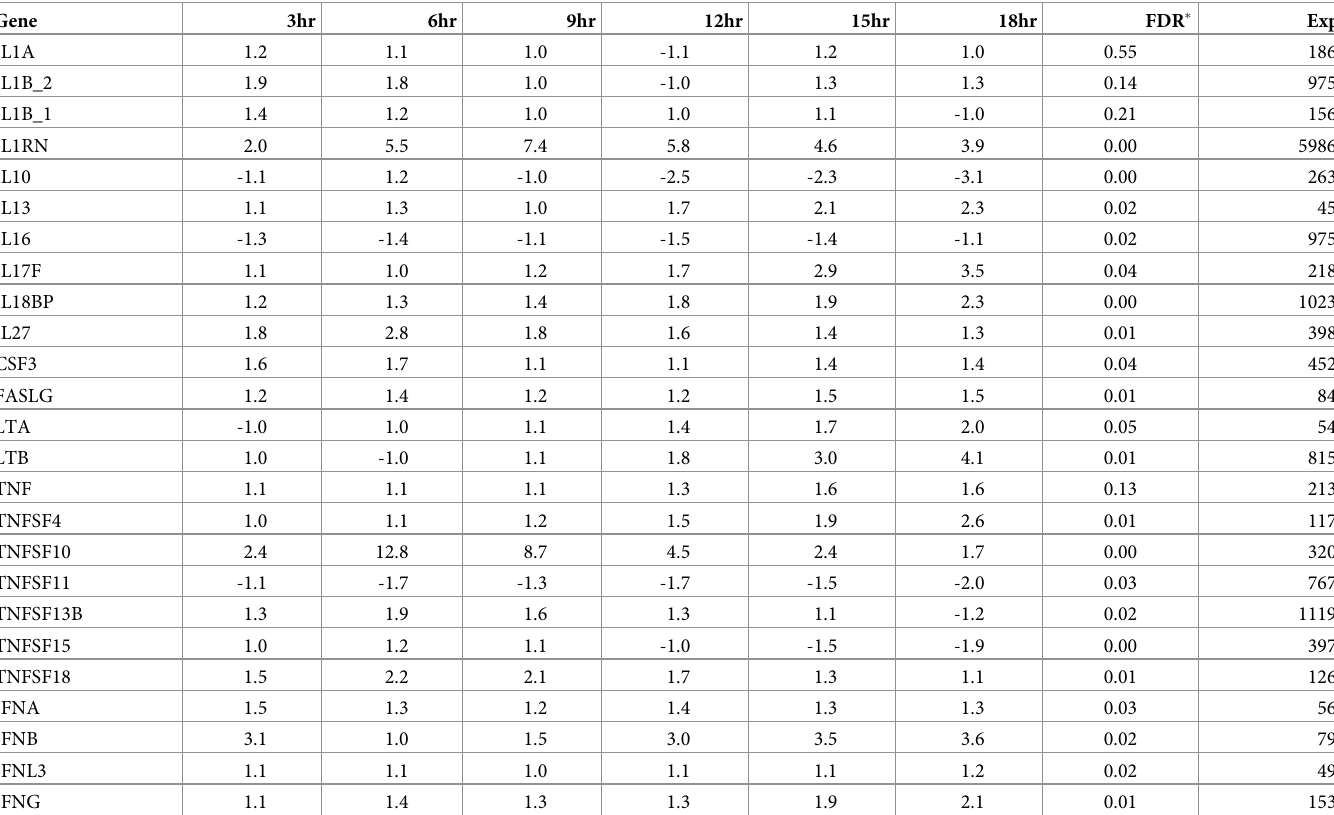
Table 3. Differential expression (fold = infected/non-infected) with a FDR less than 0.05 at one or more time points and the averaged expression level (Exp) of cyto- kine genes between infected and non-infected macrophages at 3, 6, 9, 12, 15 and 18 hours post infection.